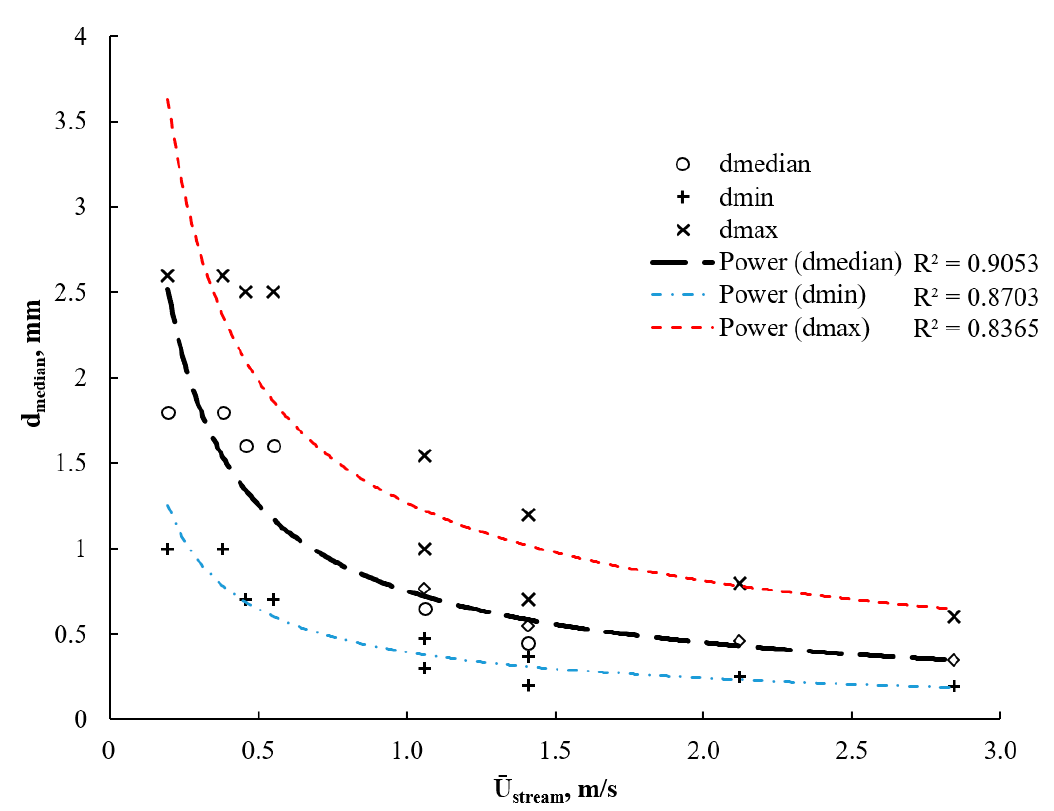
Figure 13. Mean bubble size in the aerated water flow at different stream flow rates. The circle marks denote the results from PIV, while the rhomboids are from HSC.